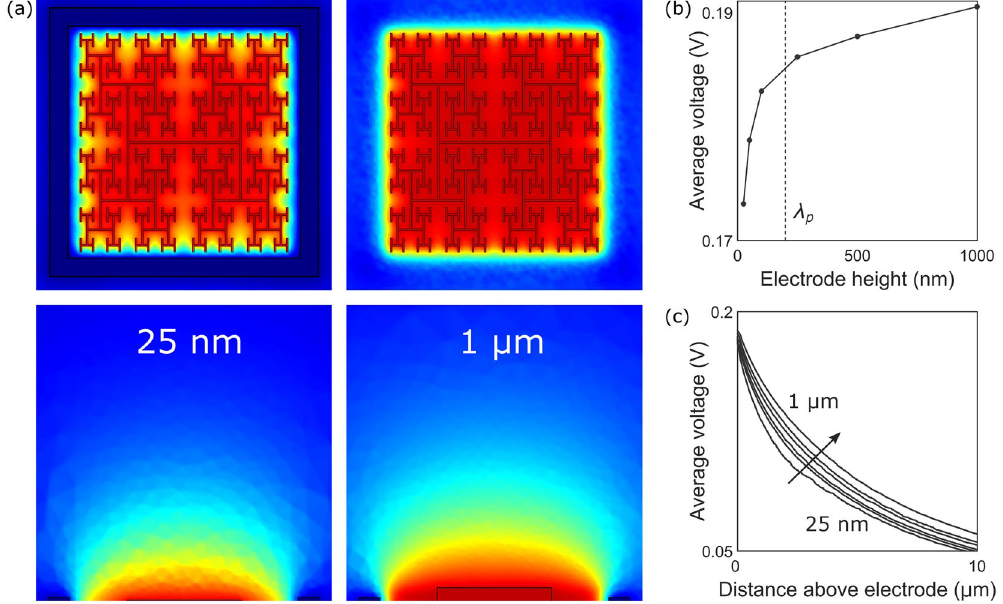
Figure 3. ( a ) Maximum extracellular voltages reached during each oscillation for inner electrode heights of 25 nm (left) and 1 µ m (right). In each case, the applied voltage was V 0 = 0.2 V and f = 1 kHz. The scale ranges from 0 V (blue) to 0.2 V (red). A horizontal slice (at the inner electrode’s top surface) of the three-dimensional voltage distribution is shown in the top row. Vertical slices through the middle of the electrodes are shown in the bottom row. ( b ) The average voltage at the inner electrode surface (averaged across locations within the bounding perimeter) for varying electrode heights. The penetration depth, λ p , occurs at 200 nm. ( c ) The average voltages plotted as a function of distance above the inner electrode surface for inner electrode heights of 25 nm, 50 nm, 100 nm, 250 nm, 500 nm, and 1 µ m (bottom to top).